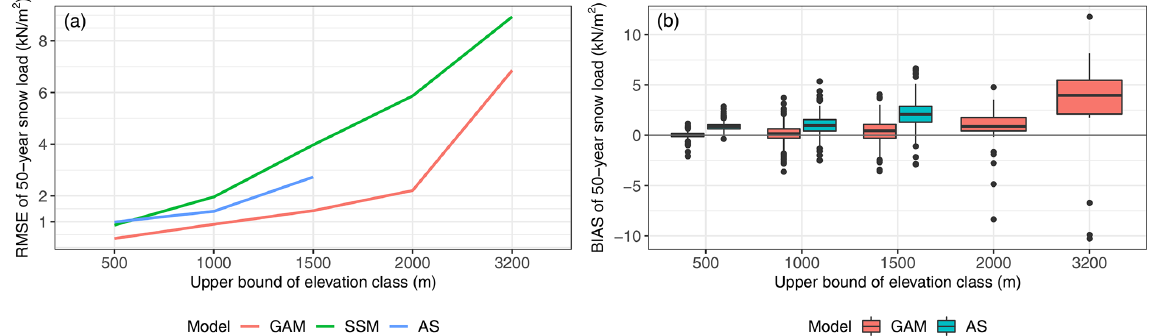
Figure 4. RMSE (a) and bias (b) of 50-year snow loads for the different models and the Austrian standard (AS) classified by elevation. GAM stands for the generalized additive model, SSM for the smooth spatial model. The corresponding number of values within the elevation classes can be found in Fig. 2. Note that the current Austrian standard is not valid for elevations above 1500m.